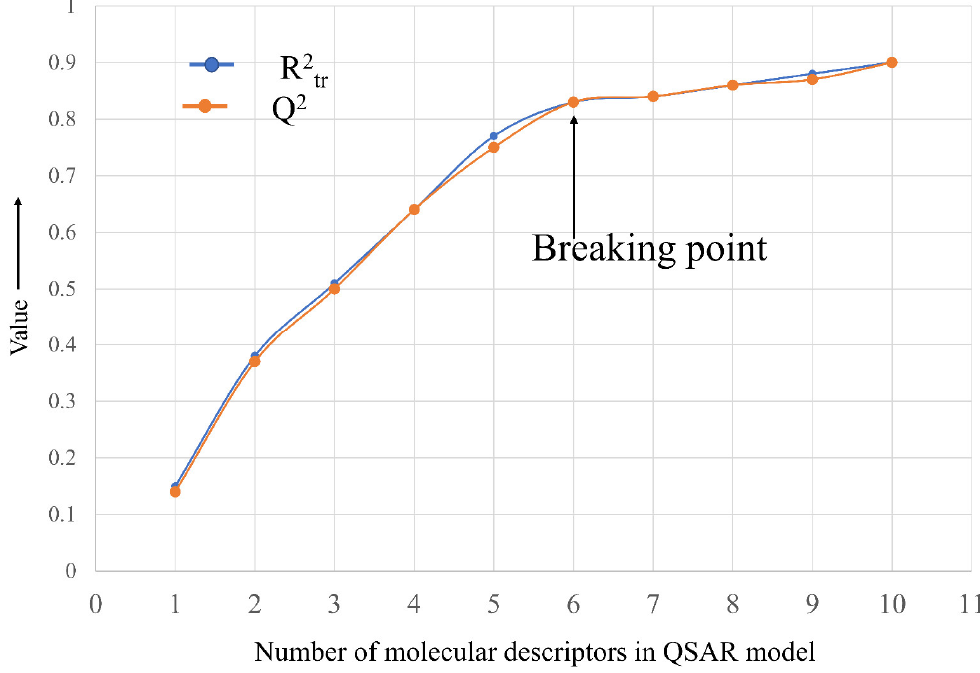
Figure 9. Plot of number of descriptors against coefficient of determination R 2 tr and leave-one-out coefficient of determination Q 2LOO to identify the optimum number of descriptors.